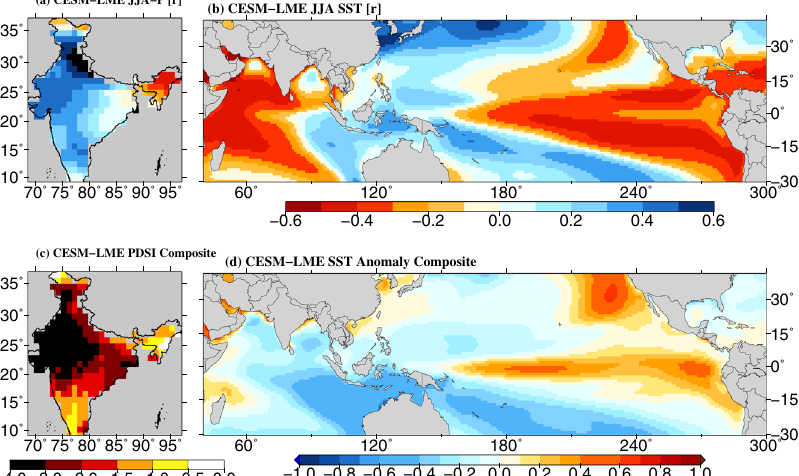
Fig. 5 The role of sea-surface temperature during megadroughts in CESM large millennium ensemble (LME). a , b Composite heterogeneous correlation ( r ) patterns of coupled variability of the summer monsoon precipitation and SST obtained from the fi rst leading mode of maximum covariance analysis (MCA) from the 12 ensemble members of CESM-LME. MCA was conducted on JJA precipitation and SST anomalies using the CESM-LME for each ensemble member for the 850 – 2005 period. c Composite Palmer Drought Severity Index (PDSI) for all the megadroughts that occurred in the 12 ensemble members of CESM-LME, d composite sea surface temperature (SST) anomaly during the